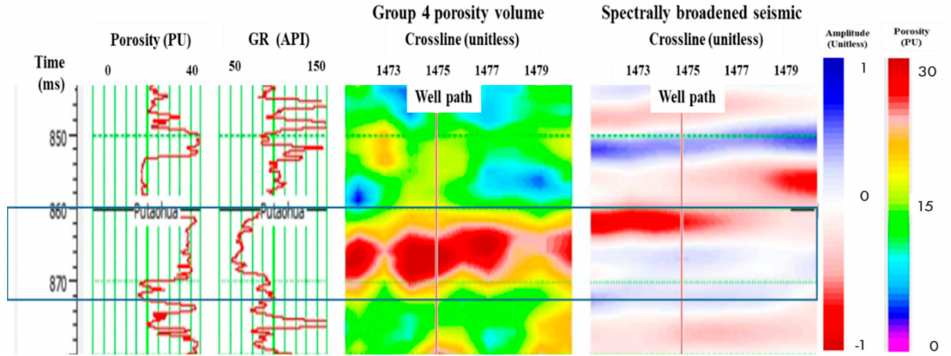
Figure 17. From left to right: porosity and gamma-ray log. Group 4 predicted porosity volume, with a red line indicating the well path, corresponding to the spectrally broadened seismic section. The blue rectangle highlights the channel-like feature. Polarity: an increase in amplitude corresponds to an increase in acoustic